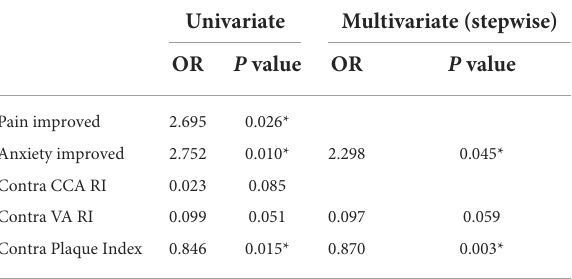
TABLE 4 Logistic regression model for Barthel Index assessment. TABLE 5 Logistic regression model for NIHSS